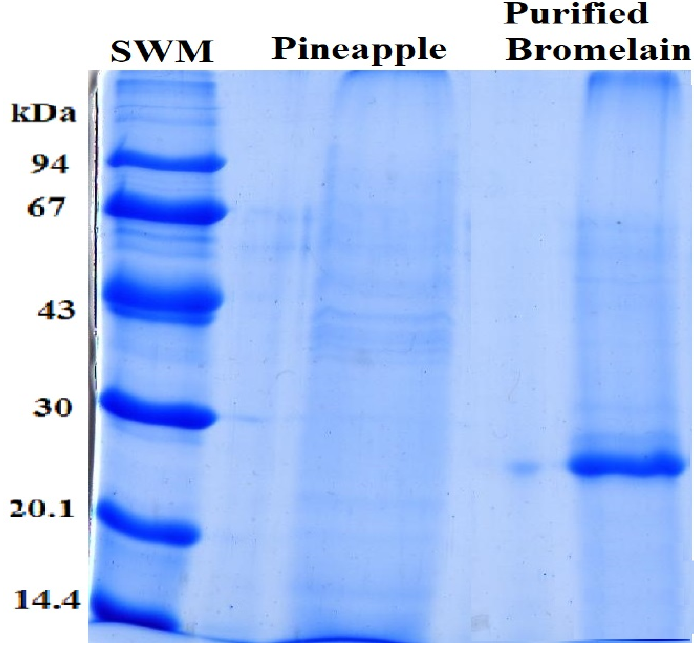
Polymers 2022 , 14 , x FOR PEER REVIEW Figure 7. Molecular weight determination by SDS-PAGE electrophoreses. Figure 7. Molecular weight determination by SDS-PAGE electrophoreses.